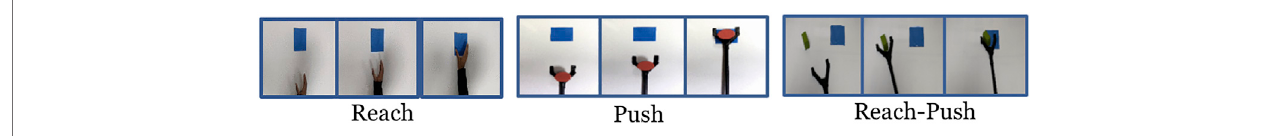
TABLE 2 | ARI scores. Results show that the features from layer pool5 and fc6 of the NN:UCF101 model are best suited to be used as action vectors. Layer ARI score Baseline-R (random weights)